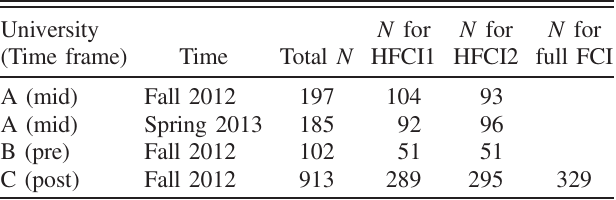
TABLE II. Sample sizes for each university in this study.